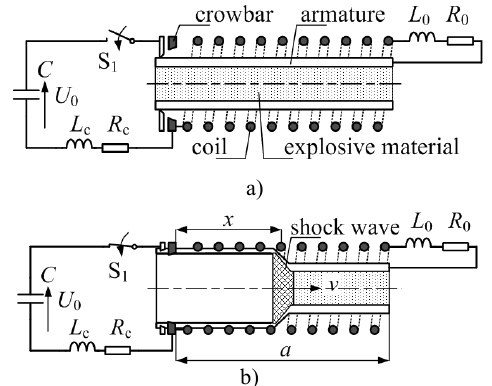
Fig. 1. FCG operation idea: a) the initial state of the system, b) magnetic field compression caused by the armature expansion process, C - capacitor bank charged to the voltage U 0 , L c , R c - connections inductance and resistance, L 0 , R 0 - load coil inductance and resistance.